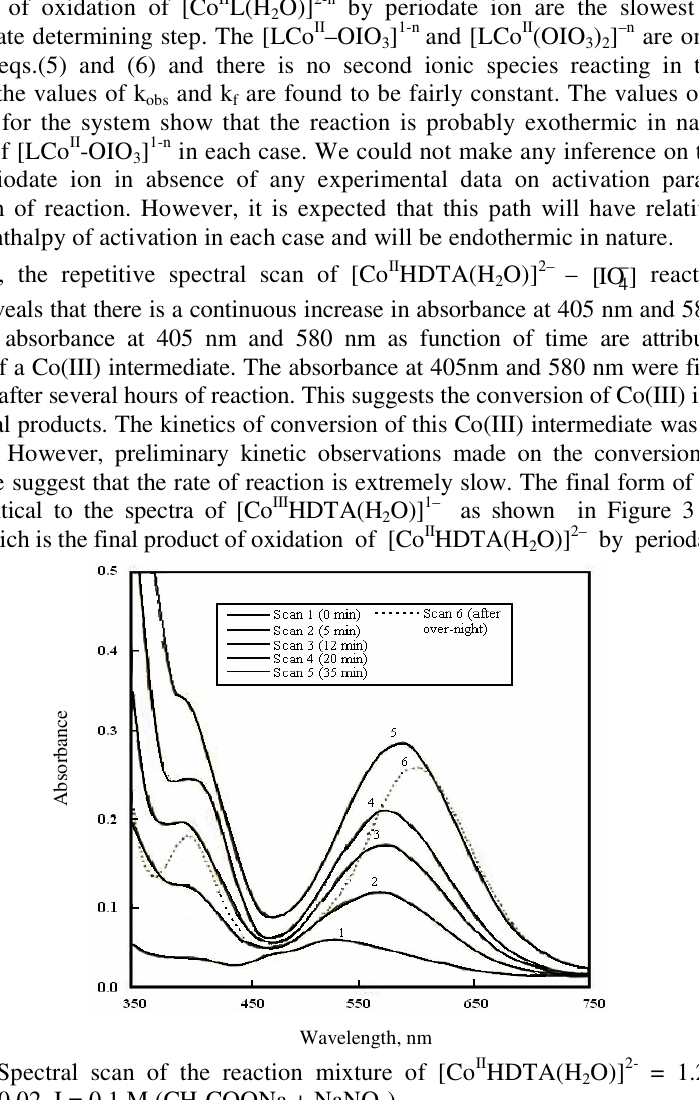
O)] 2- = 1.25 × 10 -3 M, 2 COONa + NaNO 3 3